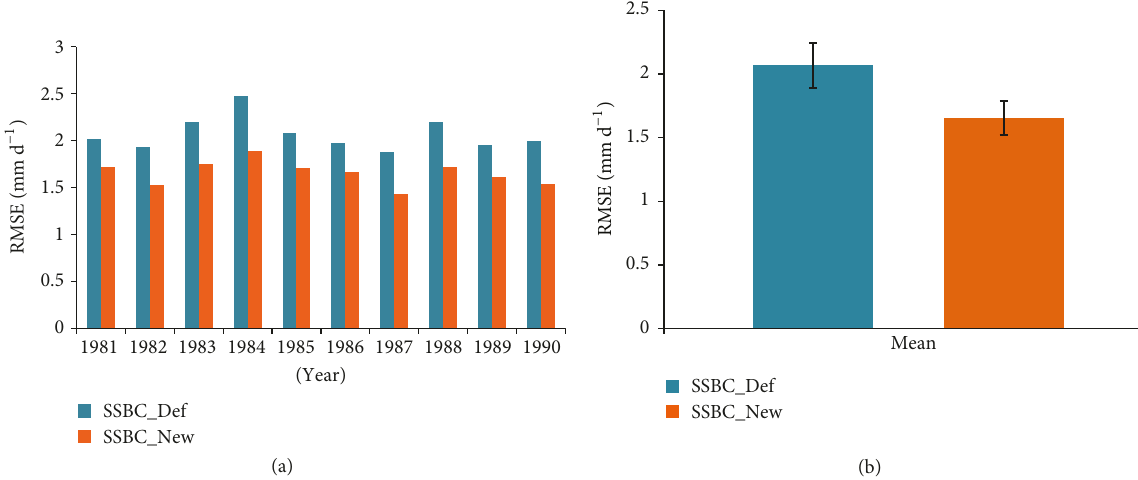
Figure 8: (a) Time series of the root-mean-square error (RMSE) of annual surface precipitation (mmd −1 ) from SSBC_Def (blue) and SSBC_New (orange) for CORDEX-SA compared with CMAP observation. (b) Mean of RMSE for 10-year period for both SSBC_Def and SSBC_New. The black error bars represent the standard deviation of both schemes from their mean value.